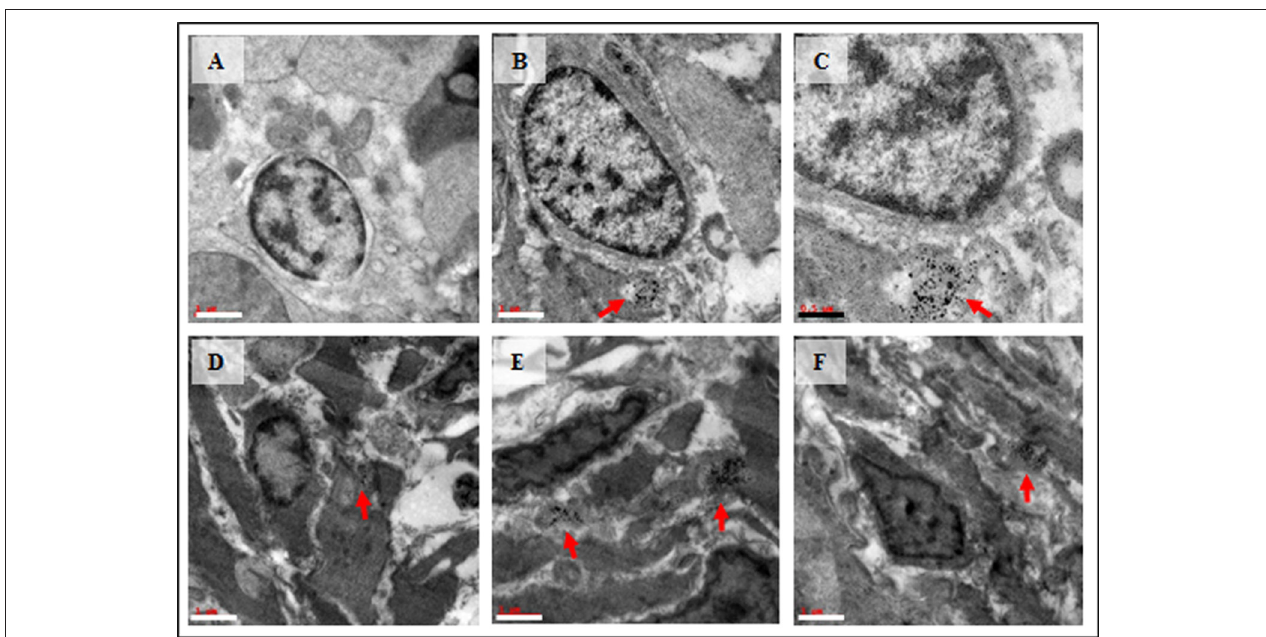
FIGURE 5 | TEM images of vacuolated spermatocyte (A) and bio-distribution of Cu-NPs in testis with apoptotic cells (B–F) in treated testis. Red arrows showed the presence of Cu-NPs in testis. Scale bar: white bar—1 µ m; black bar—0.5 µ